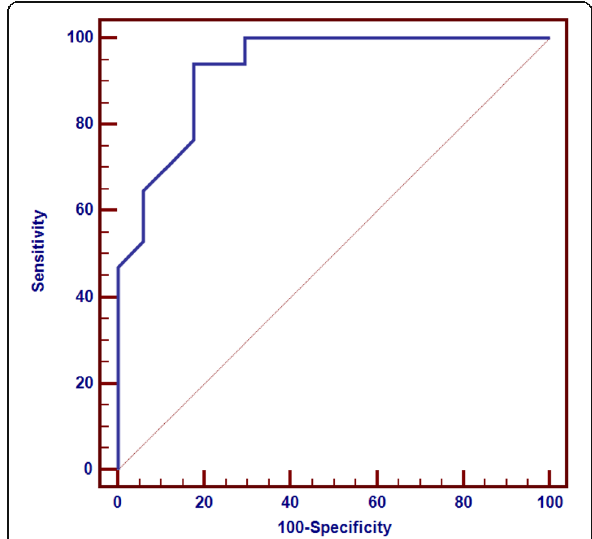
Fig. 1 ROC curves for ONSD measured in 3D DRIVE sequence in relation to raised ICP. AUC = 0.929, CI 95% = 0.786 to